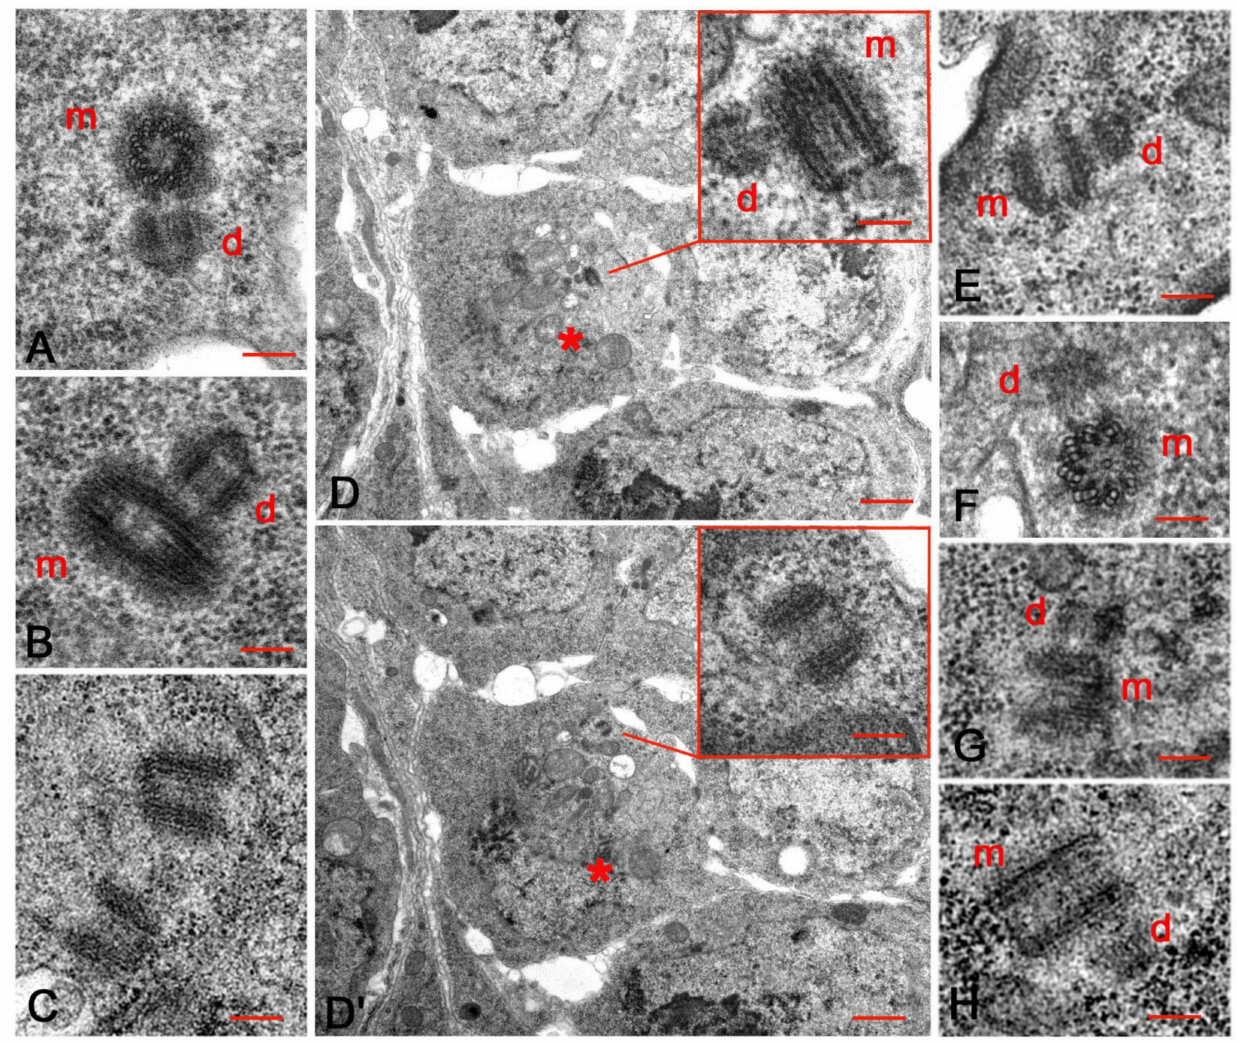
Figure 4. Centriole duplication during early Drosophila oogenesis. ( A ) Orthogonal parent centrioles in region 2a cystocytes. ( B ) Detail of an elongated centriole in region 2a with a short daughter. ( C ) Detail of two disengaged parent centrioles from a cystocyte in region 2a. ( D , D’ ) Two consecutive cross sections of a group of cystocytes in region 2a from a series of four sections, above and below the focal planes represented; the cystocyte marked by the asterisk shows one elongated centriole associated with a small daughter centriole ( D , inset) and one slightly distant, isolated centriole (inset, D’ ). Details of a pair of orthogonal centrioles within a ring canal ( E ), inside the cytoplasm of oocytes in region 2b ( F ) and stage 3 ( G ); a distinct procentriole is also visible close to one elongated centriole during stage 4 ( H ). m and d denote mother and daughter centrioles, respectively. Bars: A – C , E – H , insets D , D’ ,150 nm; D , D’ , 1 µ